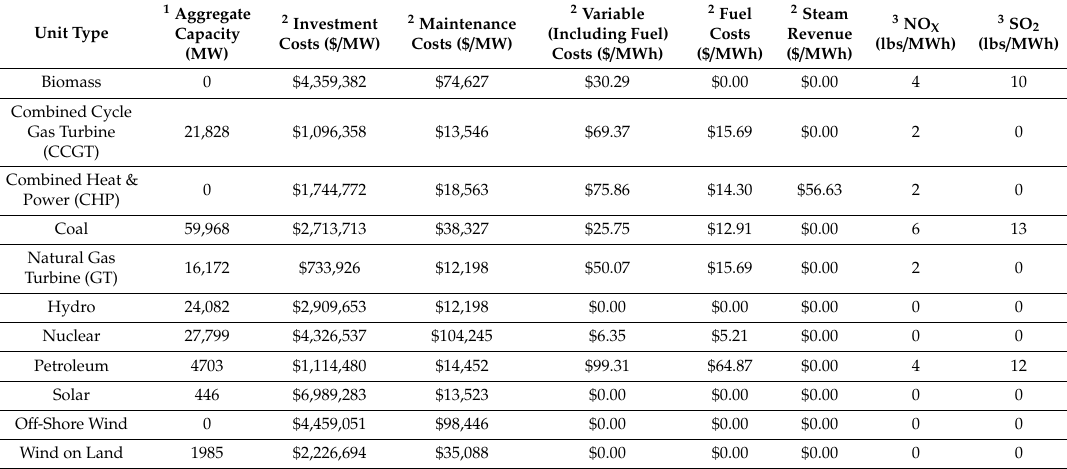
Table 4. Generating Units and Their Costs, Capacities, and Emissions